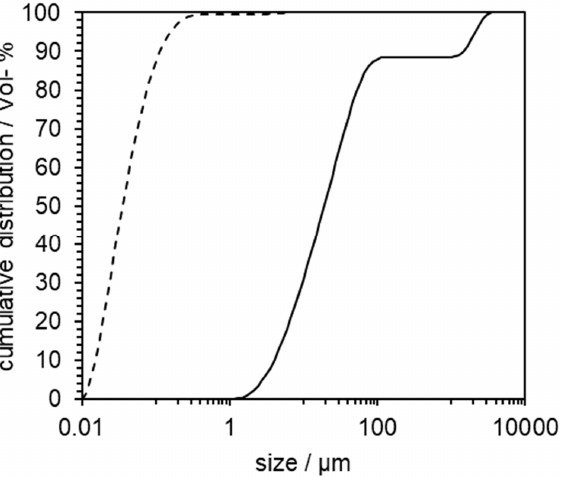
Figure 7. Cumulative particle size distribution of niclosamide suspension before (–) and after milling (- - -). Measured via laser